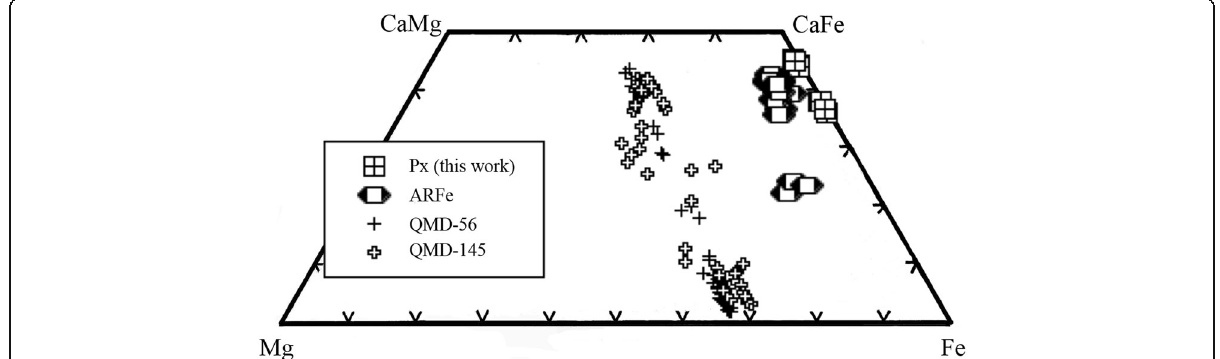
Fig. 5 Pyroxene quadrilateral compositions from the silicic clast (this work). Compositions reported by Fagan et al. (2014) for pyroxenes from NWA 773 ARFe clasts and 15405 QMD (56, 145), are also shown